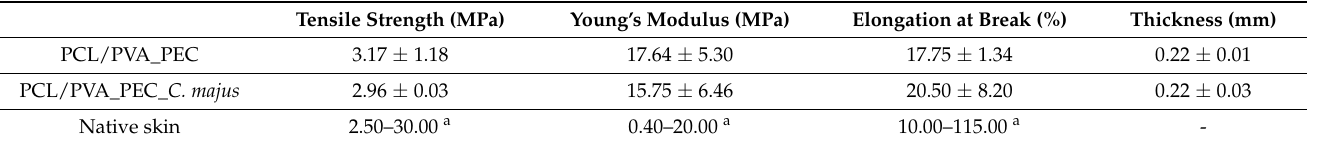
Table 1. Characterization of the mechanical behavior of the produced PCL/PVA_PEC nanofibrous meshes with and without C. majus and comparison with the mechanical features of the native human skin.